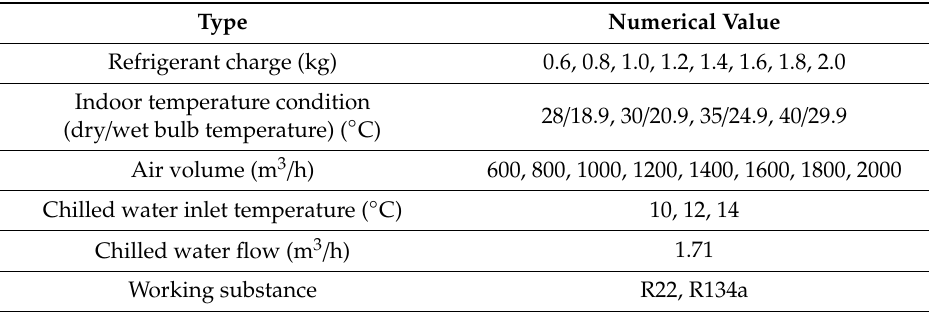
Table 1. Other experimental conditions.